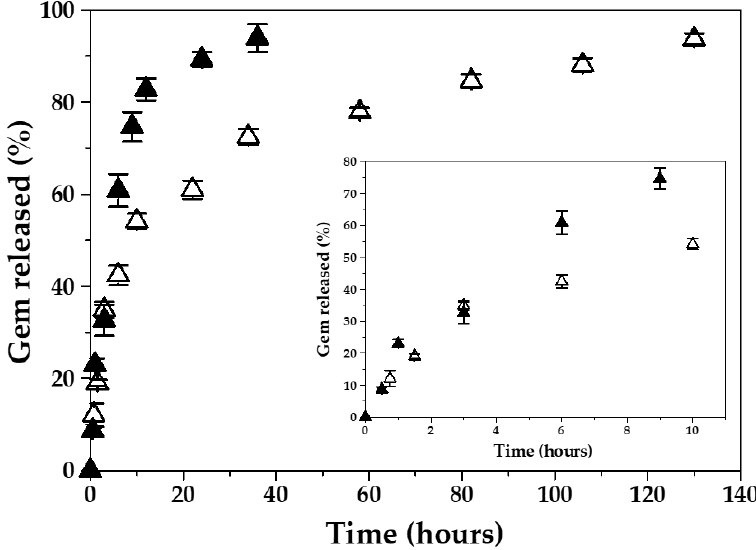
Figure 6. In vitro release of Gem (%) from the magnetic nanocomposites (of 2:4 Fe 3 O 4 :PCL weight ratio), as a function of the incubation time at 37.0 ± 0.5 °C, in citrate- phosphate buffers of 7.4 ± 0.1 (∆) and of pH 5.0 ± 0.1 ( ▲ ). Inset: Gem released (%) up to t = 10 h.